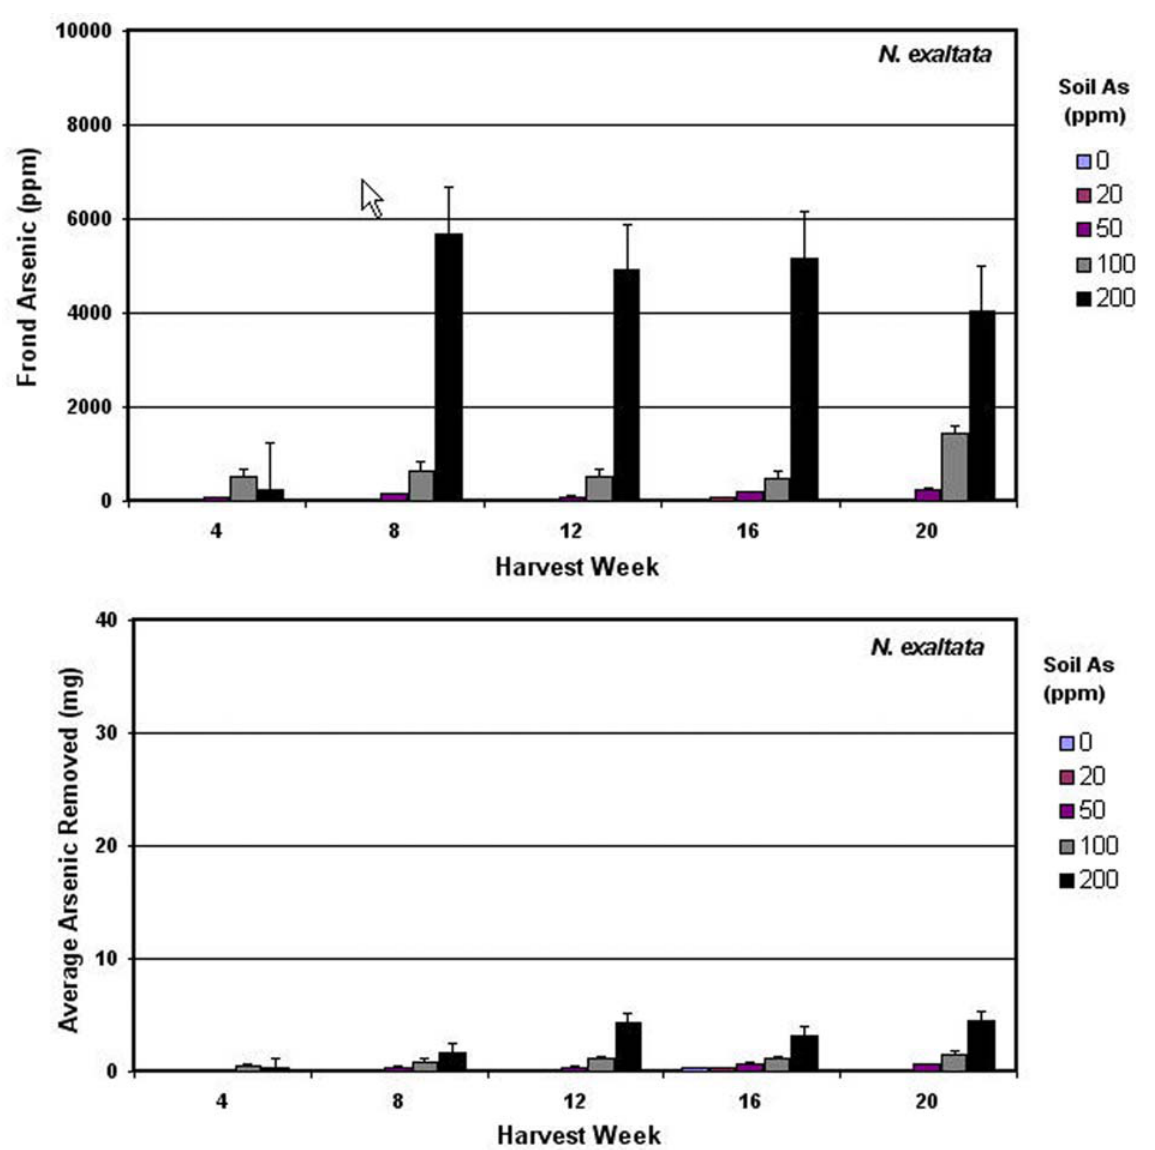
Figure 6. Arsenic uptake summary for Nephrolepis exaltata. Arsenic concentration and content in the control fern Nephrolepis exaltata . One of the surprising results was the consistently high frond arsenic concentrations of Nephrolepis exaltata ferns grown in the 200 ppm arsenic/soil concentration. Whiskers show the standard error. Table 1 lists uptake values by week and soil